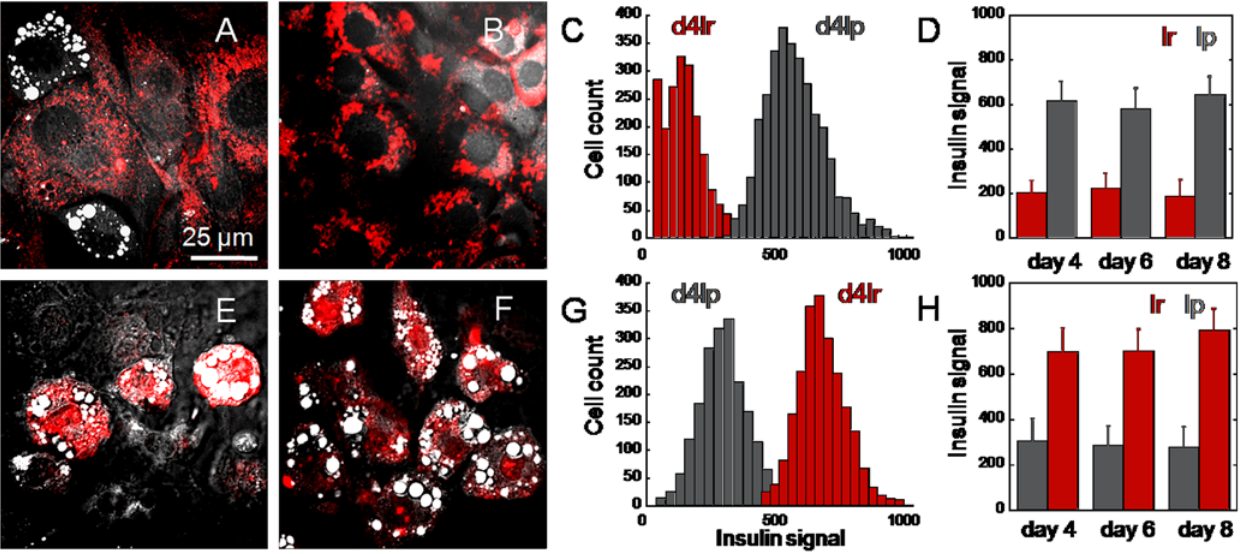
Figure 4. Insensitivity to new insulin stimulation in lipid-poor cells. ( A ) Absence and ( B ) presence of insulin-Cy3 signal in lipid-rich and lipid- poor cells, respectively. Cells were treated with insulin-Cy3 on day 2 and images taken on day 4. ( C ) Flow cytometry analysis of insulin-Cy3 signal in lipid-rich (red) and lipid-poor cells (grey) of cell samples presented in ( A ) and ( B ). 4lr and 4lp represent sorted lipid-rich and lipid-poor populations at day 4 after adipogenesis induction, respectively. ( D ) Quantitative analysis of insulin-Cy3 signal in lipid-rich (lr) and lipid-poor (lp) sorted cell populations at different days after adipogenesis induction. Insulin-Cy3 was added every 2 days to cell cultures until day 4 and day 6 for analysis on day 6 and day 8, respectively. Error bars represent distribution across 4 repeated experiments. Two thousand cells were evaluated with flow cytometry for each experiment. ( E ) Lipid-poor cells exhibit insulin resistance, whereas ( F ) lipid-rich cells exhibit insulin sensitivity to additional insulin stimulation. Cells were treated with unlabeled insulin on day 2, then with insulin-Cy3 on day 4 for 5 minutes before imaging. ( G ) Flow cytometry analysis of insulin-Cy3 signal in lipid-rich (red) and lipid-poor cells (grey) of cell samples presented in ( E ) and ( F ). ( H ) Quantitative analysis of insulin- Cy3 signal in lipid-rich (lr) and lipid-poor (lp) sorted cell populations at different days after adipogenesis induction. Cells were treated with unlabeled insulin every 2 days until the day of analysis, when insulin-Cy3 was added for 5 minutes before imaging. Error bars represent distribution across 4 repeated experiments. Two thousand cells were evaluated with flow cytometry for each experiment.